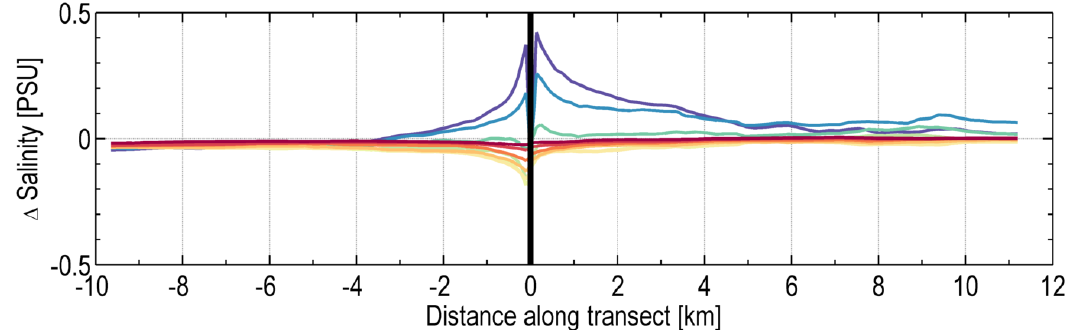
Figure 22. Difference in salinity due to HCB relative to test 1, plotted along Transect-b for all model layers. The plot shows average salinity difference for all hourly time steps over the calibration period of 25 April–11 June 2017. (The distance between −10 km and 0 km represents the region south of the bridge, while that between 0 km and 10 km represents the region north of the bridge).